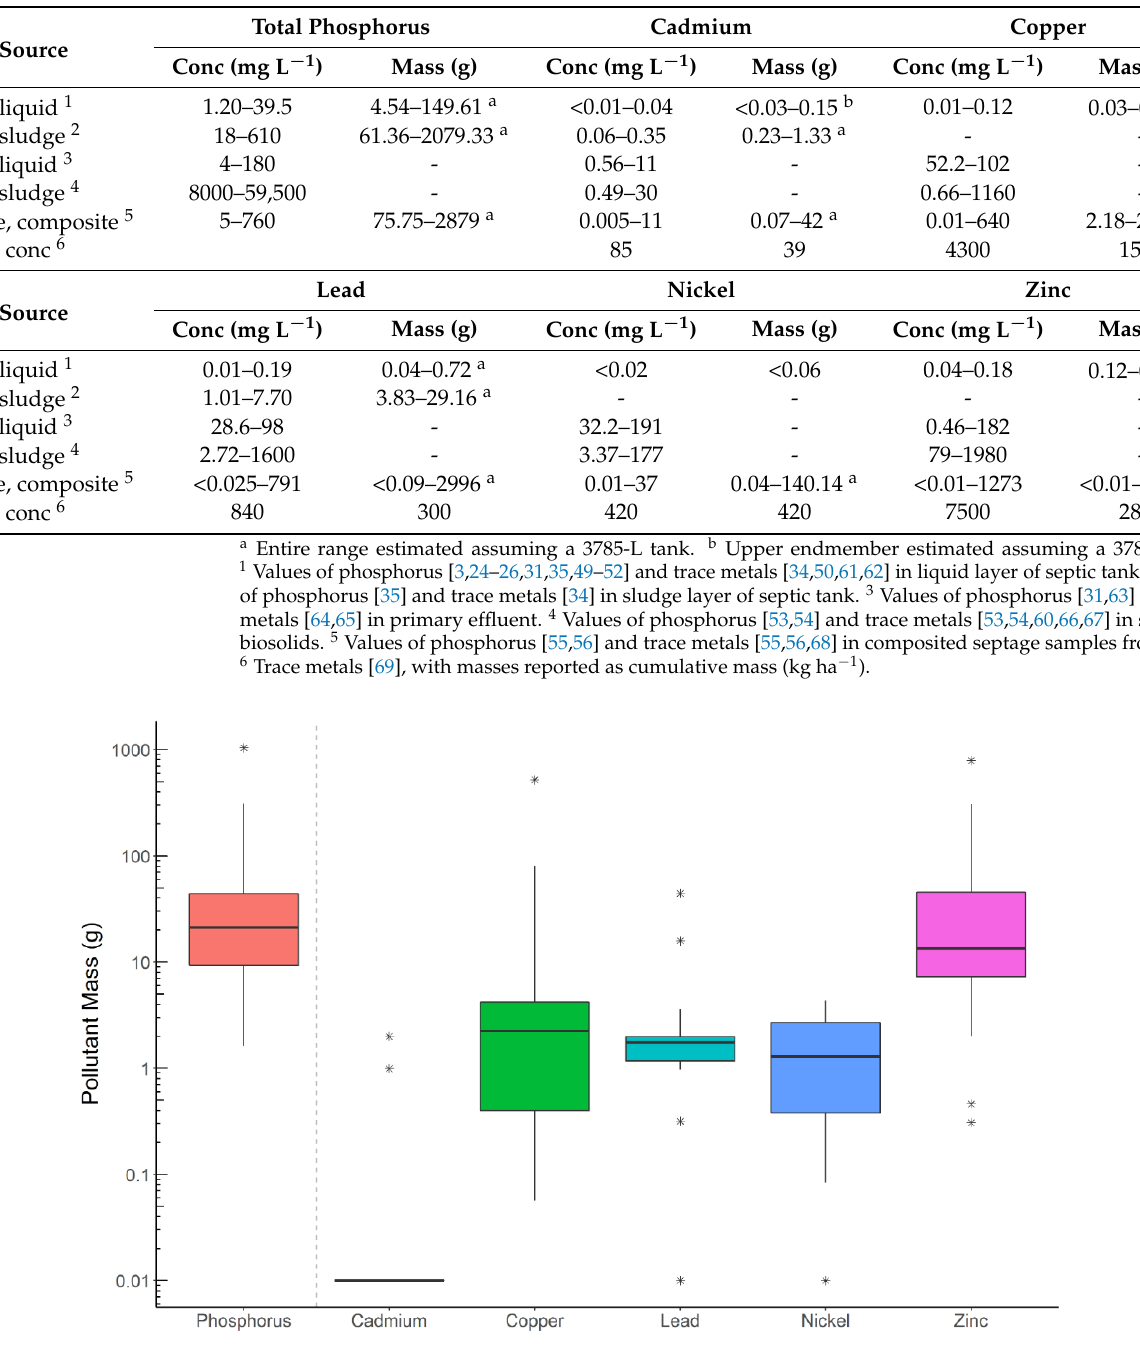
Figure 4. Boxplot of total masses for total phosphorus, cadmium, copper, lead, nickel, and zinc in the studied septic tanks ( n = 37). Asterisks (*) represent outliers. Table 4. Estimated mass in all septic systems in the studied sub-watershed ( n = 87) based on the median and mean concentrations of total phosphorus (TP) and trace metals from the studied septic tanks ( n = 37).